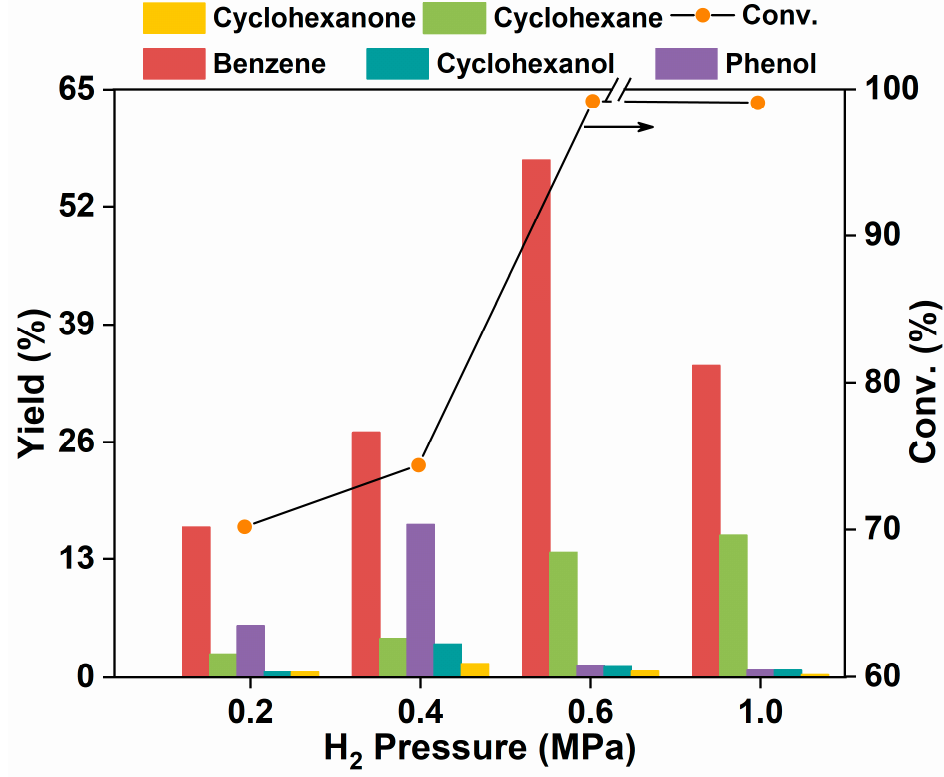
Figure 7. Effects of initial H 2 partial pressure on the hydrogenolysis of diphenyl ether over Ru- Ni 12 P 5 /S-1 5 .